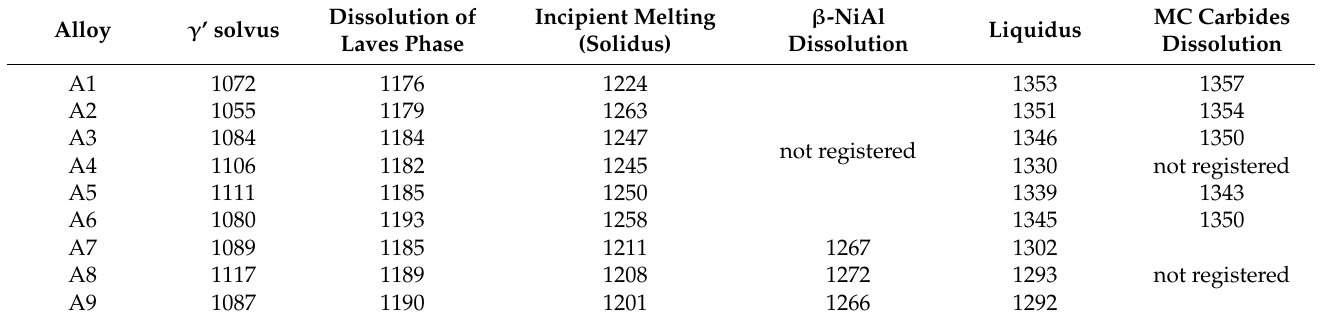
Figure 20. Representative DSC heating curves with a heating rate of 10 K min −1 for the as-cast superalloys. Table 5. Phase transformation temperatures of the A1–A9 superalloys registered during DSC heat- ing.